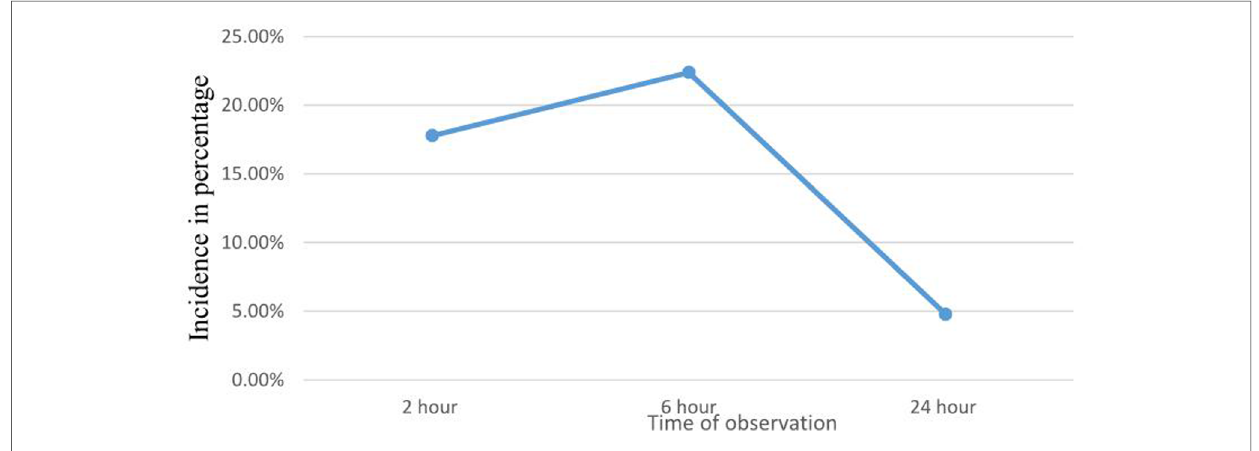
FIGURE 1 Incidence of POST in each time of observation among pediatric patients at Northwest Amhara Referral Hospitals, from March 1 to June 30, 2022 ( N